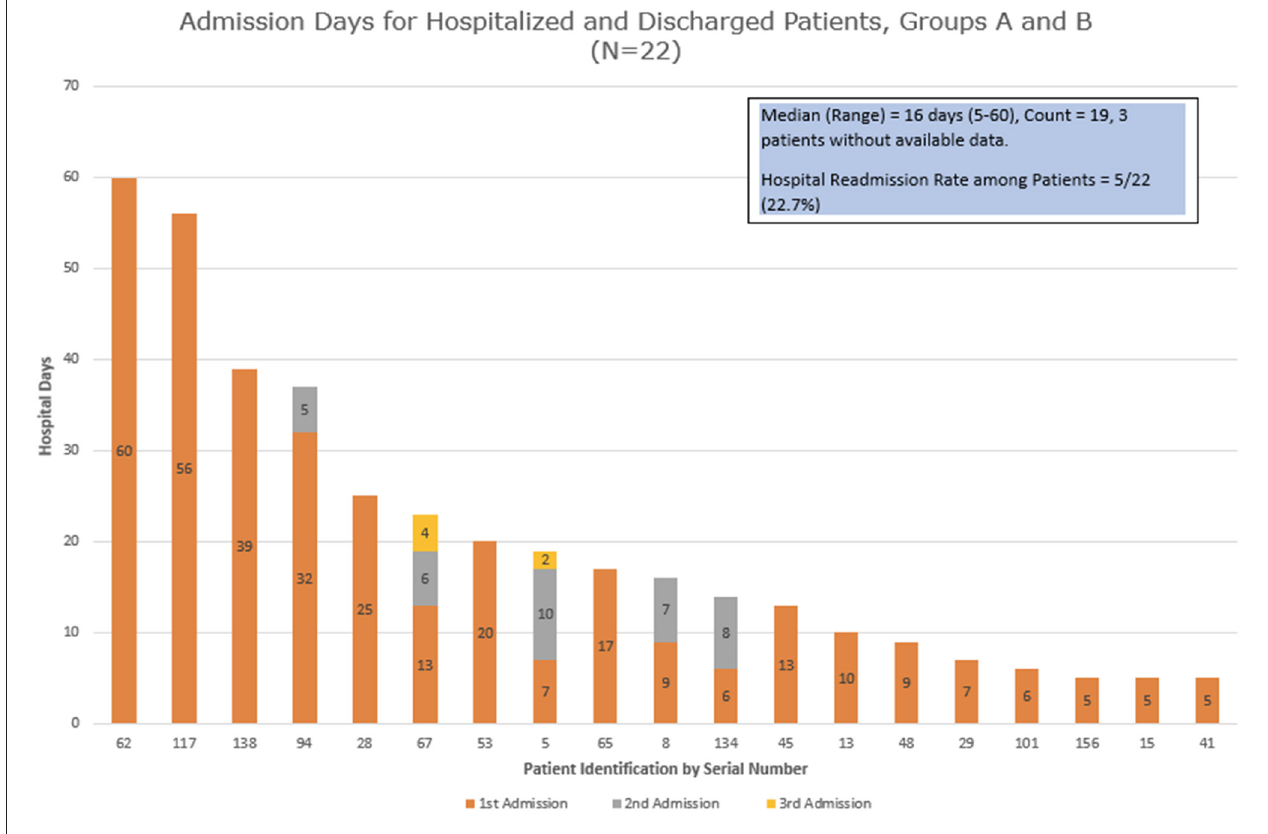
FIGURE 2 | Admission days for hospitalized and discharged patients.